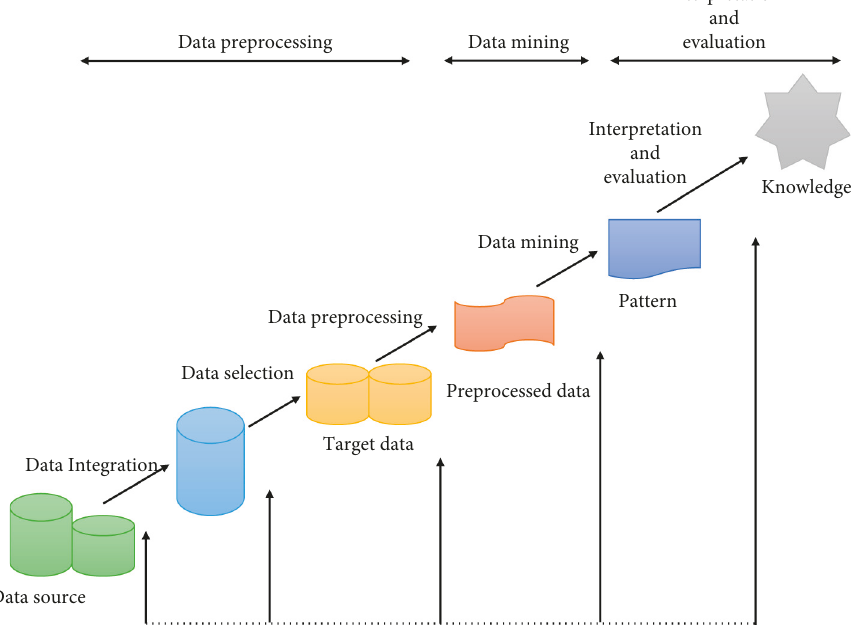
Figure 4: Data mining